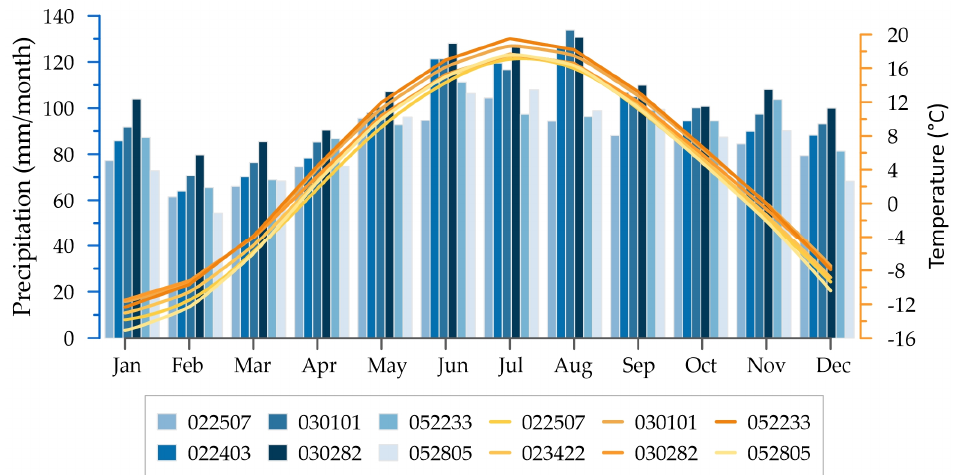
Figure 2. Monthly precipitation and temperature averages for all basins. Table 1. Main catchment characteristics and climatology. P : total precipitation. T : mean annual tem- perature. ET: evapotranspiration. SWE : snow water equivalent.